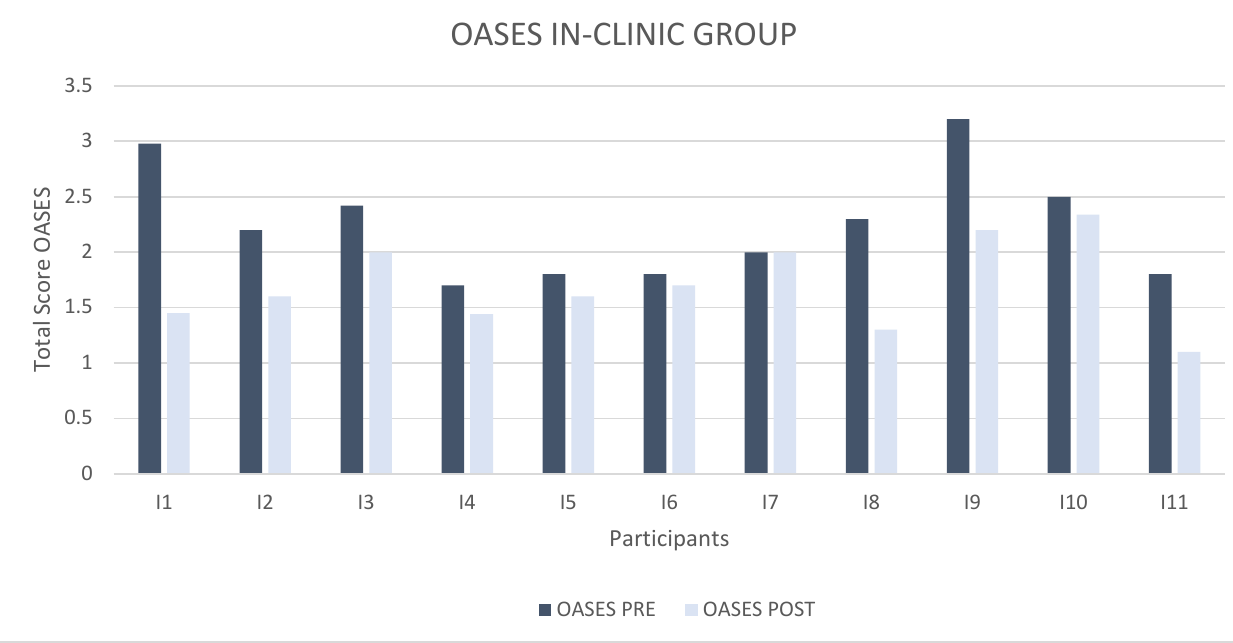
OASES Total Score pre and post treatment for the In-Clinic Group